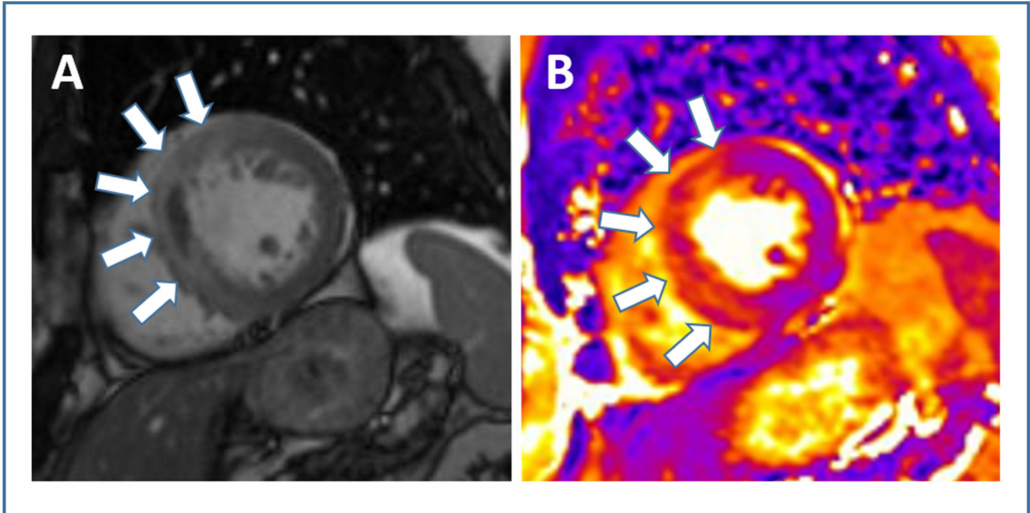
Figure 3. Cardiac magnetic resonance approaches to estimate myocardial area-at-risk in acute STEMI. In a case example of a STEMI patient with anterior wall infarction, area at risk is illustrated by contrast-enhanced cine SSFP (( A ) white arrows) and T2-mapping (( B ) white arrows). Abbreviations: STEMI, ST-elevation myocardial infarction; SSFP, steady-state free